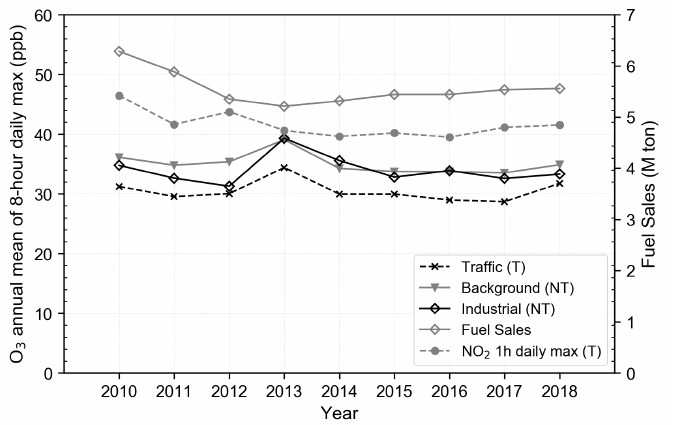
Figure 18. Lisbon O 3 annual mean of 8-hour daily max in traffic (T) and non-traffic (NT) AQMS versus fuel sales, similar to Figure 2 but this time for